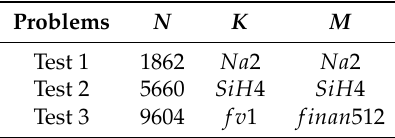
Table 5. The matrices K and M in Test 1–3.